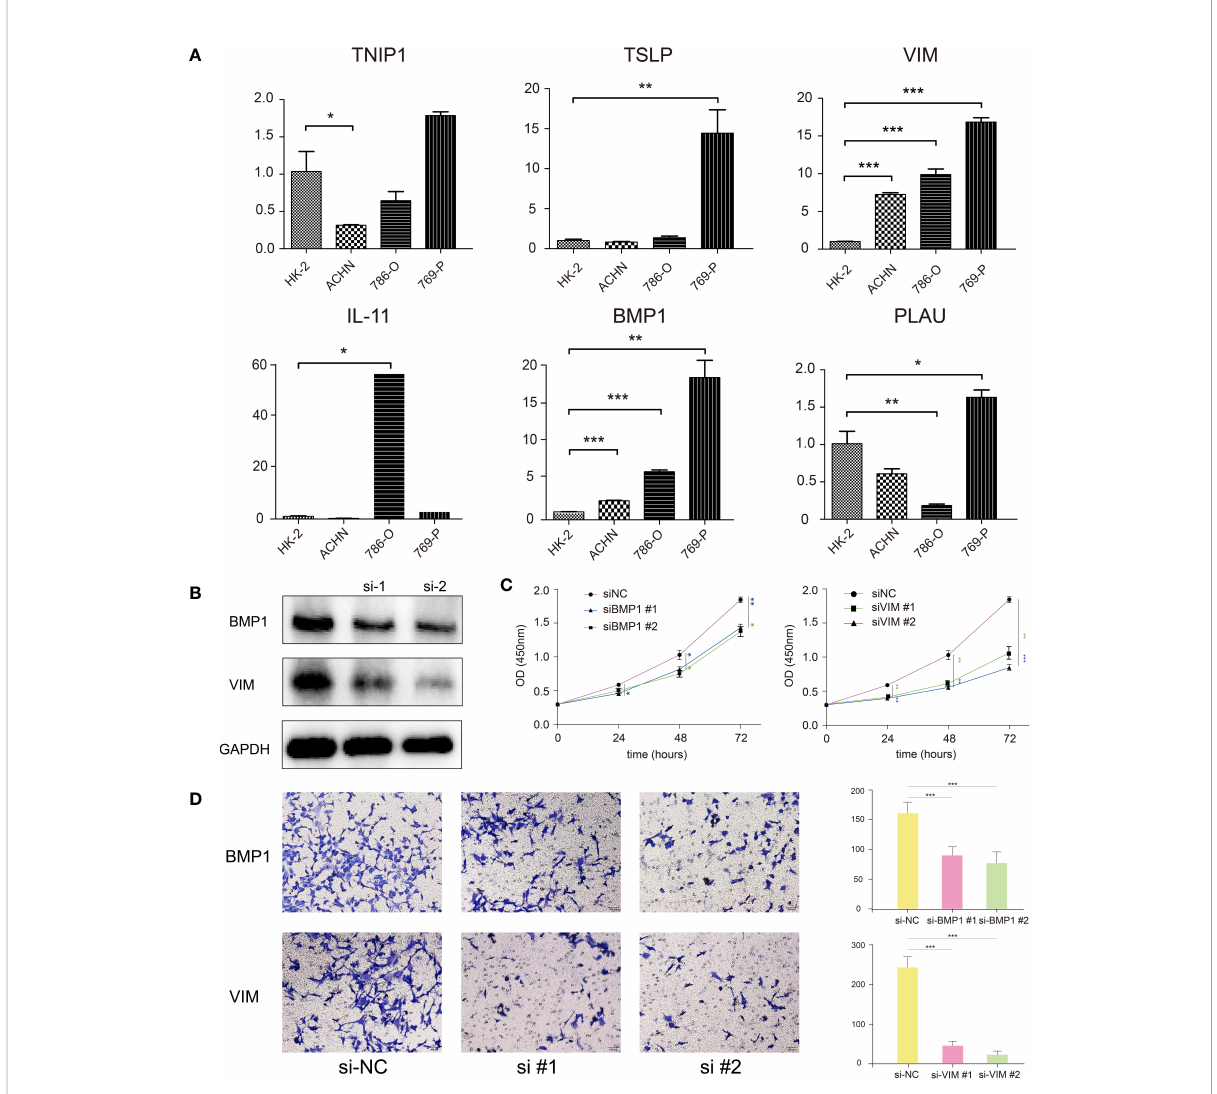
FIGURE 8 (A) RT-qPCR con fi rmed the difference of the prognostic gene expression in normal renal and renal cell carcinomas. (B) Western blotting showed that the BMP1 and VIM genes were effectively suppressed after siRNA transfection. (C) CCK-8 assay suggested that the proliferation ability of 769-P cells was reduced with BMP1 and VIM knockdown. (D) Transwell assay showed that the invasion ability of 769-P cells was reduced with BMP1 and VIM knockdown. * P < 0.05, ** P < 0.01, *** P <